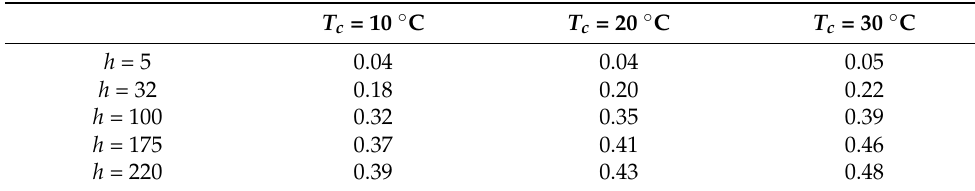
Table 13. Maximum exchange current density difference at the negative electrode ( ∆ i 0 ,p,max_diff ) in the discharge process (A/m 2